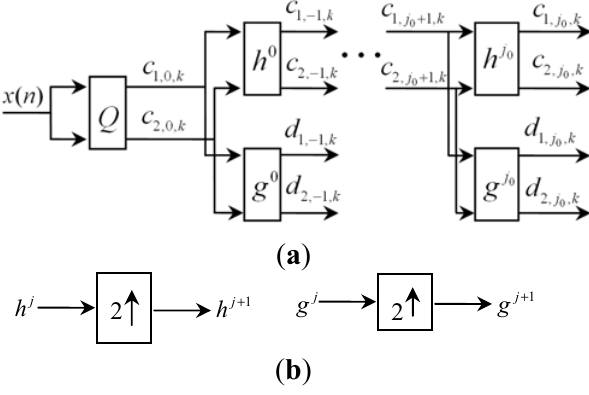
Figure 3. The decomposition of redundant multiwavelet transform. ( a ) Decomposition of redundant multiwavelet transform. ( b ) Zero-padding of filter